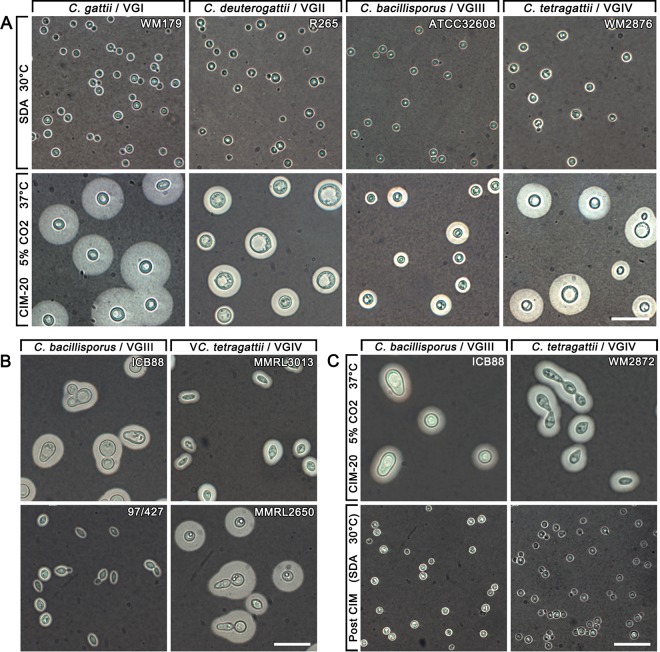
Capsule enlargement and morphologically irregular cells following growth under capsule-inducing conditions. (A) Indian ink preparations of representative strains from each species showing capsule enlargement when grown on CIM with 5% CO2 at 37°C for 5 days compared to growth on SDA at 30°C for 5 days. (B) Growth on CIM-20 with 5% CO2 at 37°C induced irregular, elongated cell shapes, particularly in C. bacillisporus/VGIII and C. tetragattii/VGIV strains. (C) Normal growth resumed following subculture on SDA at 30°C. Bars = 20 µm.